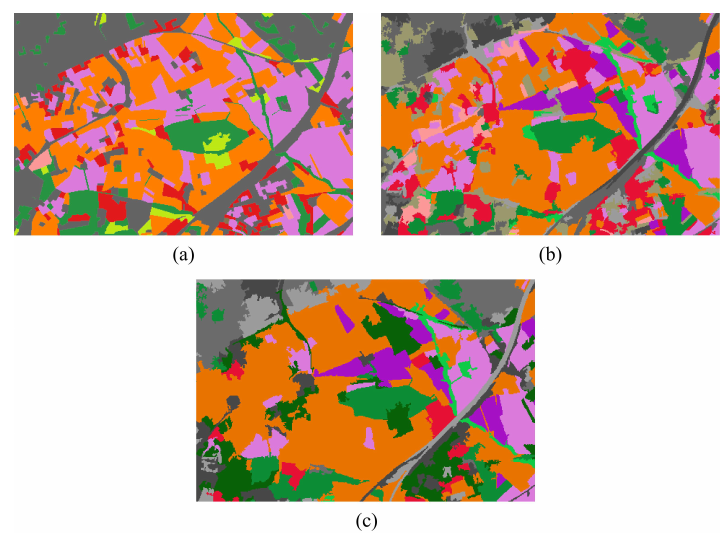
Figure 4. Example of clustering results highlighting the advantage of our proposed segmentation correction. ( a ) ground truth (GT) for 2017 year, ( b ) results for our method for the Sentinel-2 dataset, ( c ) results for our pipeline without segmentation correction for the Sentinel-2 dataset (clustering performed on objects extracted from the segmentation of two most representative images). The clusters are colored accordingly to the GT map. The reference map legend can be consulted on Figure